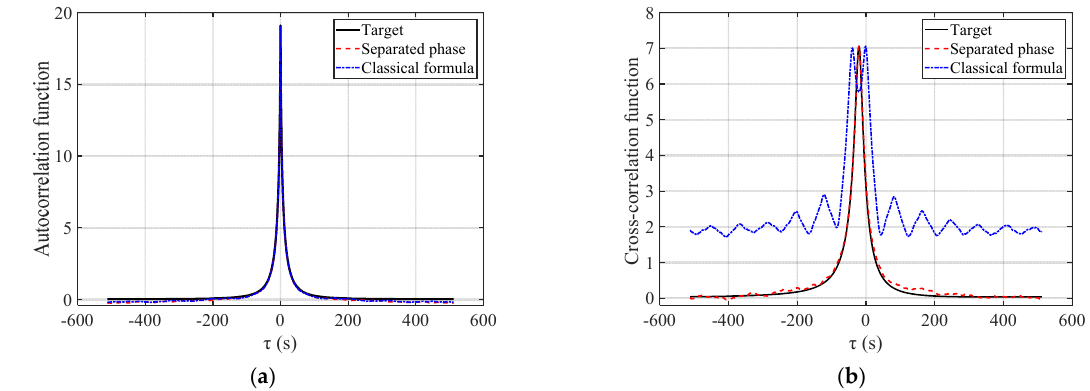
Figure 4. Estimated correlation functions by nonergodic stationary wind fluctuation samples (1000 samples): ( a ) 21,21 ( ) R τ ; ( b ) 1,21 ( ) R τ .